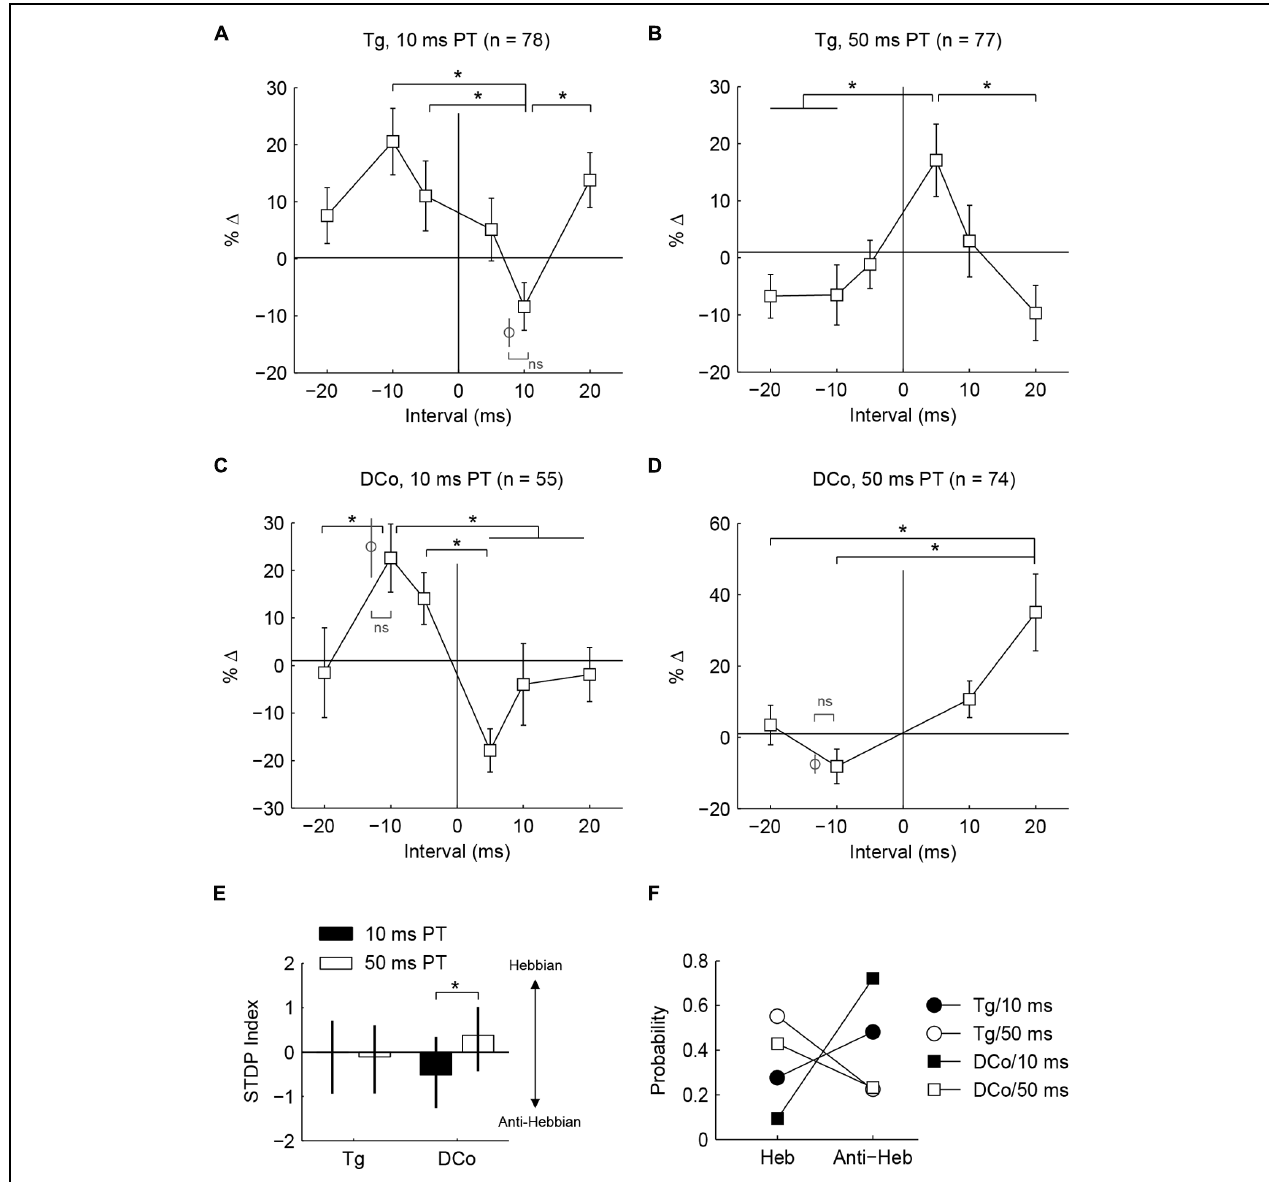
FIGURE 4 | Whether population timing rules are Hebbian or anti-Hebbian depends on PT duration. (A–D) Percent changes in mean tone-evoked rates as functions of bimodal intervals (timing rules) corresponding to Figures 3C–F . Additional data points (gray circles) outside of line plots were collected in control experiments wherein a single bimodal interval was used in one experiment (ns: no significance; ∗ P < 0.05)